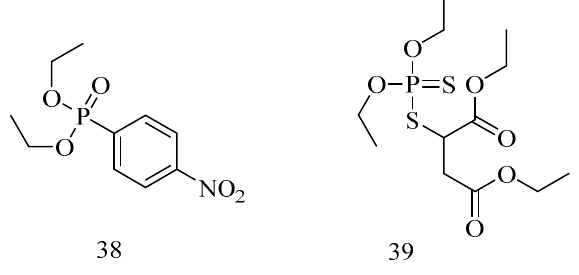
Figure 12. Organophosphorus pesticides paraoxon and malathion.